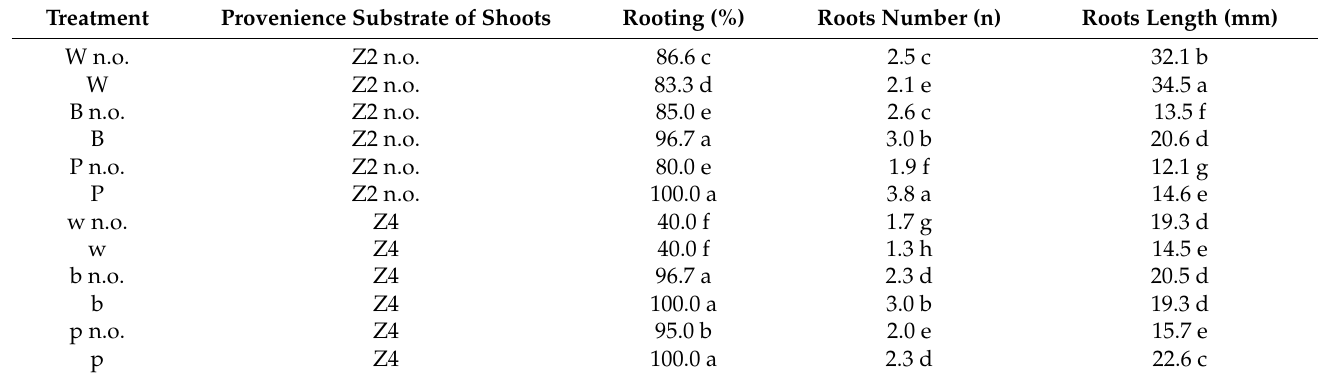
Table 2. Parameters related to root